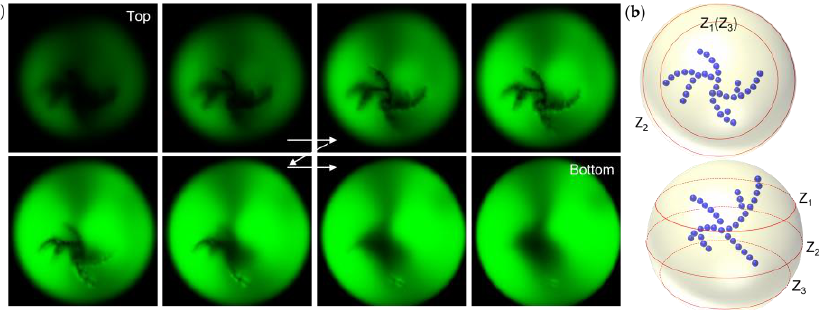
Figure 3. The geometry of the laser-processed CLC droplet in Figure 2. ( a ) Using a confocal micro- scope, the sequenced images illustrate the geometry of the CLC droplet in each vertical section; ( b ) 3D reconstruction of the distribution of ND assembly within the host CLC droplet.